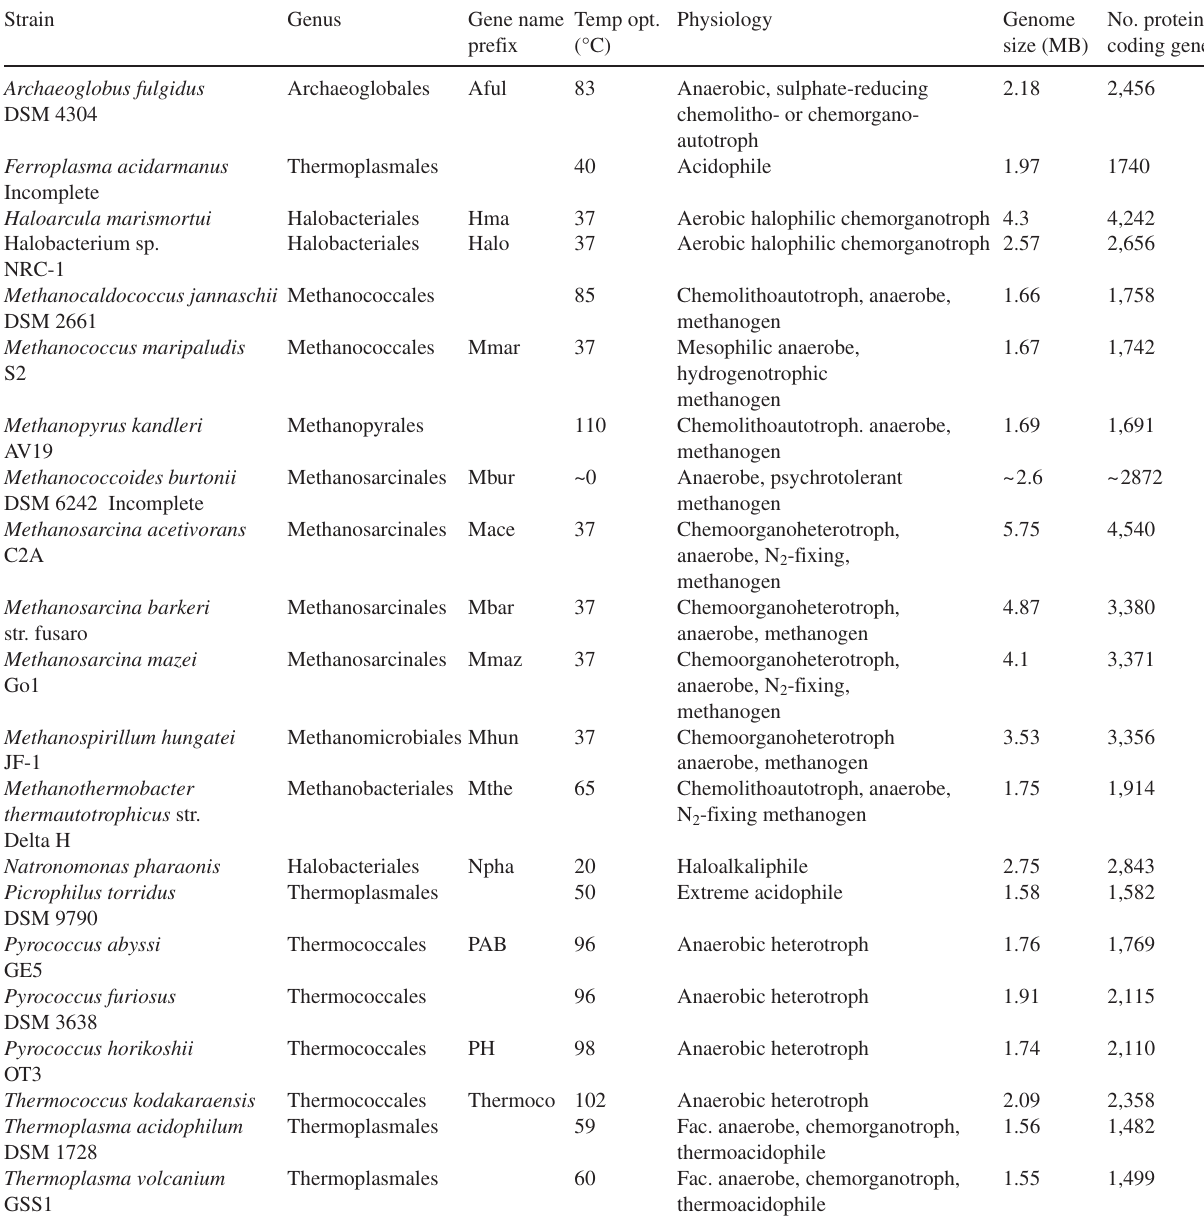
Table 1. Strain description of members of the Euryarchaea for which there are publicly available genome sequences as of October 2005. The gene name prefix is used with the gene designations to aid in identification of the